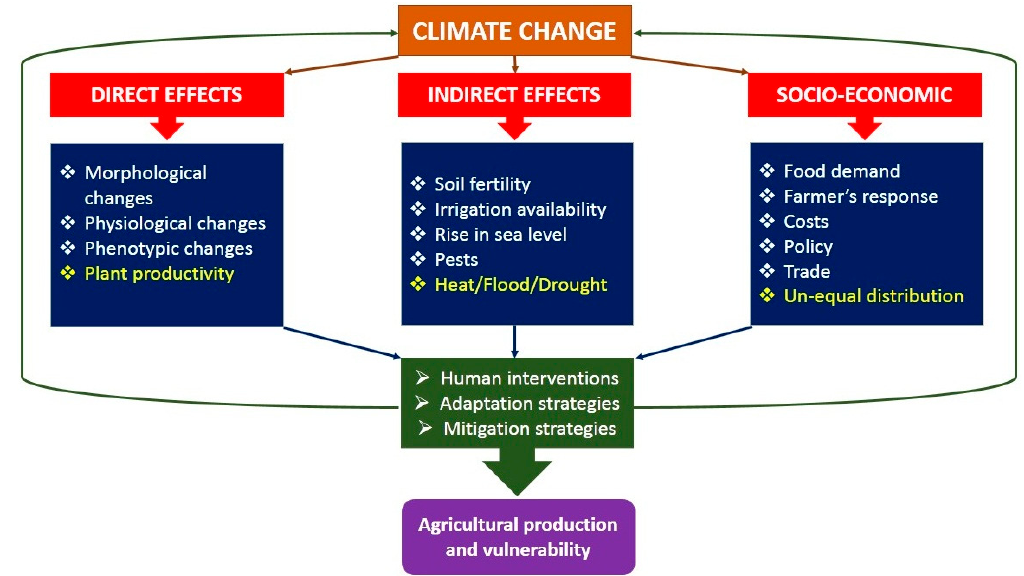
Figure 1. Direct, indirect and socio-economic effects of climate change on agricultural production.